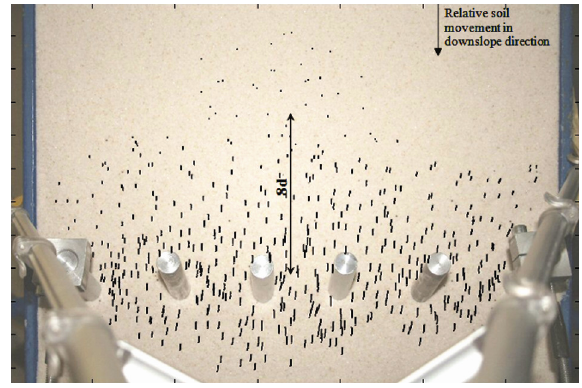
Fig. 8. The overall relative soil surface displacements throug- hout the test the free head pile test with s/d =